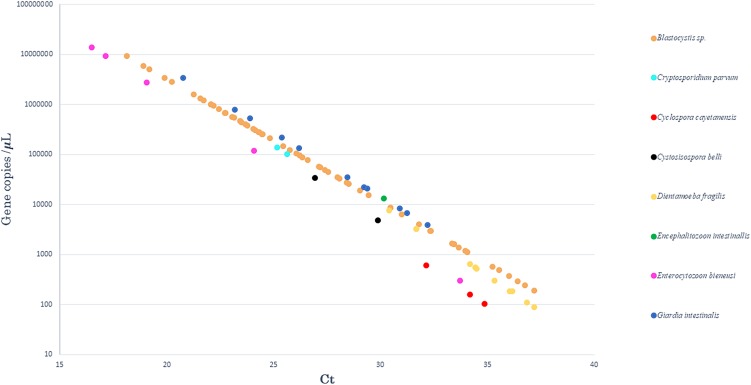
Results obtained after quantification by qPCR. The curve representing the number of gene copies, as a function of qPCR Ct values, in positive samples for each of the eight enteric parasites tested.